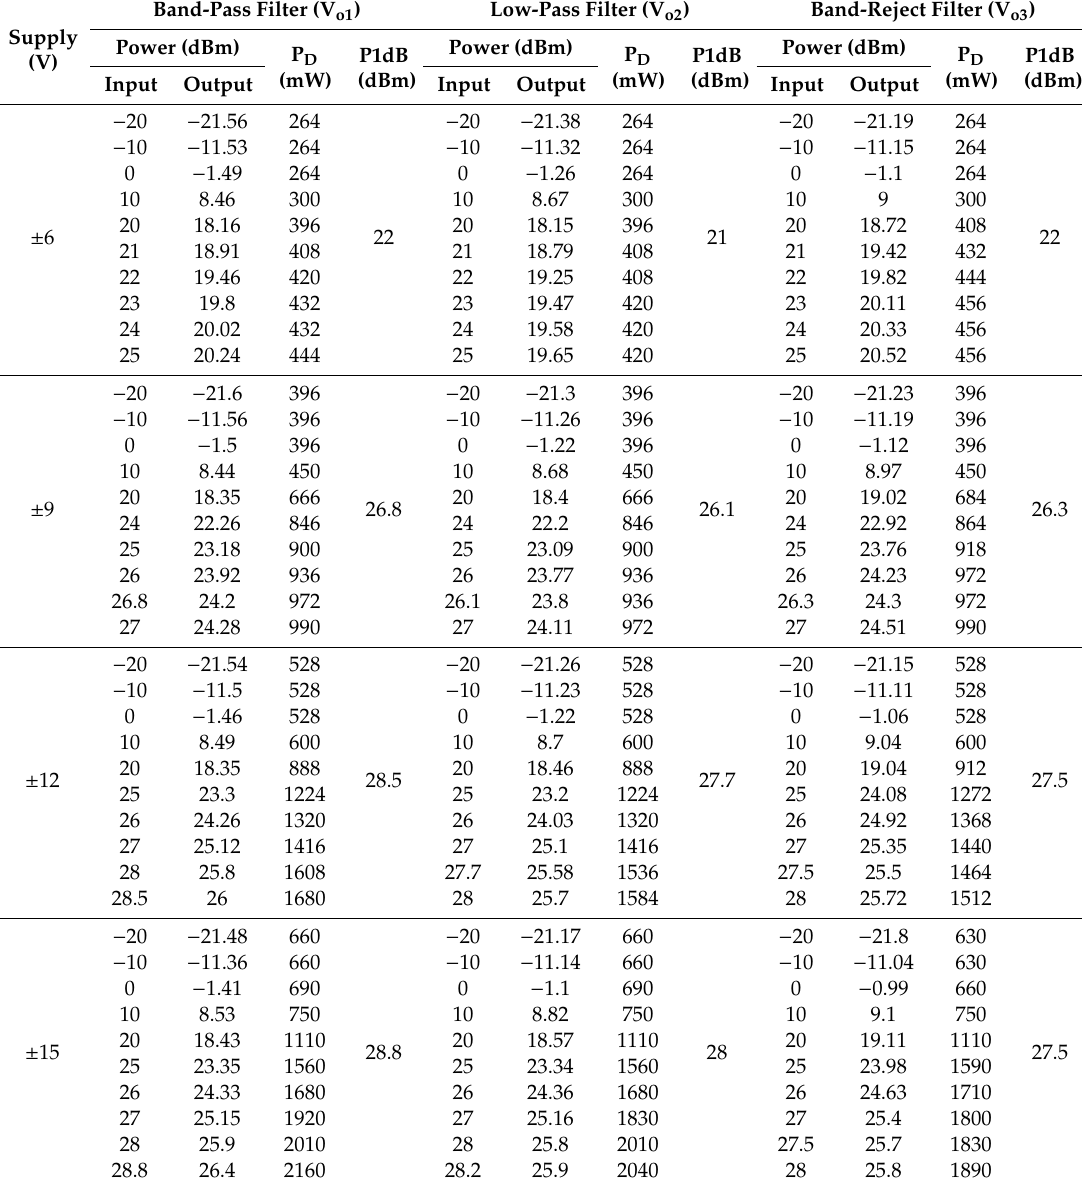
Table 3. The linearity performance of P1dB and total power consumption with di ff erent input signal voltages.